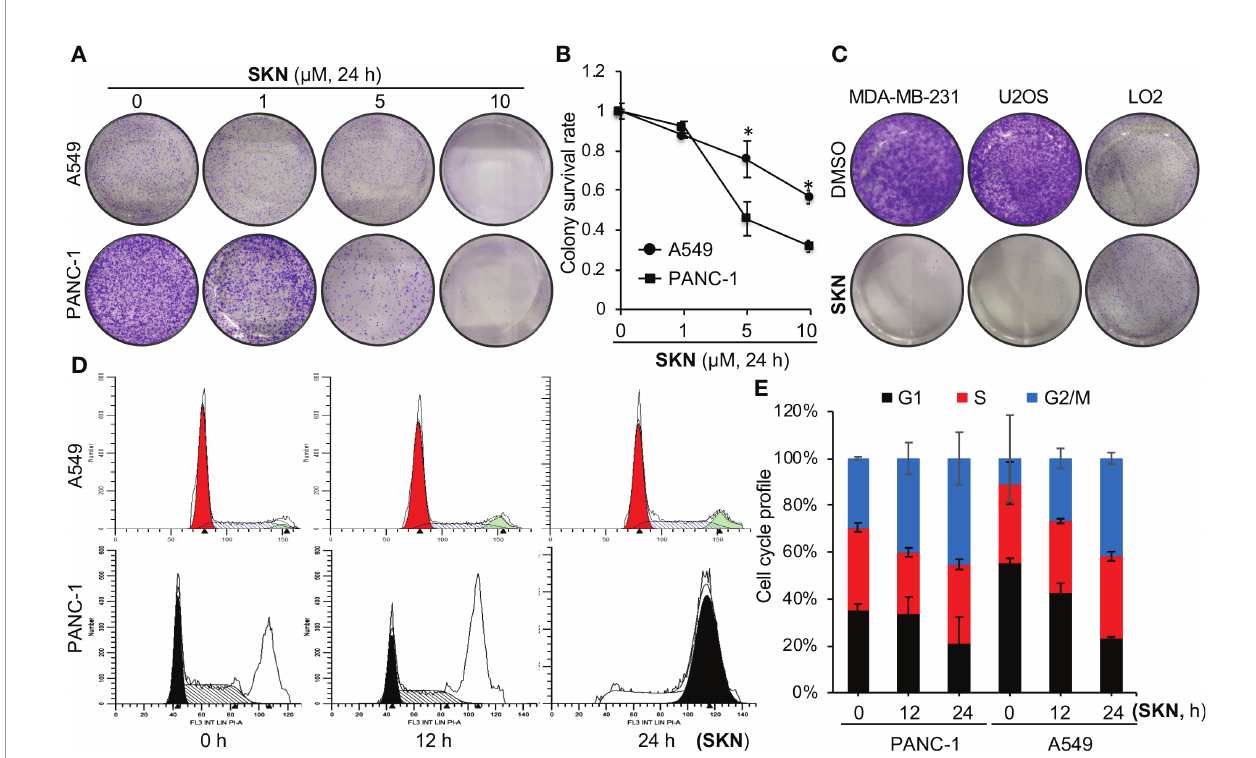
FIGURE 3 | Effects of Shikonin on cell survival and cell cycle. (A) A549 or PANC-1 cells were treated with increasing concentrations of Shikonin for 24 h, and clonogenic survival assay was measured. Representative images are shown. (B) Quantitation of relative survival from (A) . Data represent mean and standard deviation from fi ve replicates. *P <0.001 compared with the DMSO control. (C) MDA-MB-231, U2OS or LO2 cells were treated with 5 m M of Shikonin for 24 h, and clonogenic survival assay was measured. Representative images are shown. (D) A549 or PANC-1 cells were treated with 5 m M of Shikonin for 0, 12 and 24 h, fi xed and cell cycle pro fi le was analyzed. (E) Quantitation of cell cycle distribution for A549 and PANC-1 cells from D . Data represent average and standard deviation from two independent